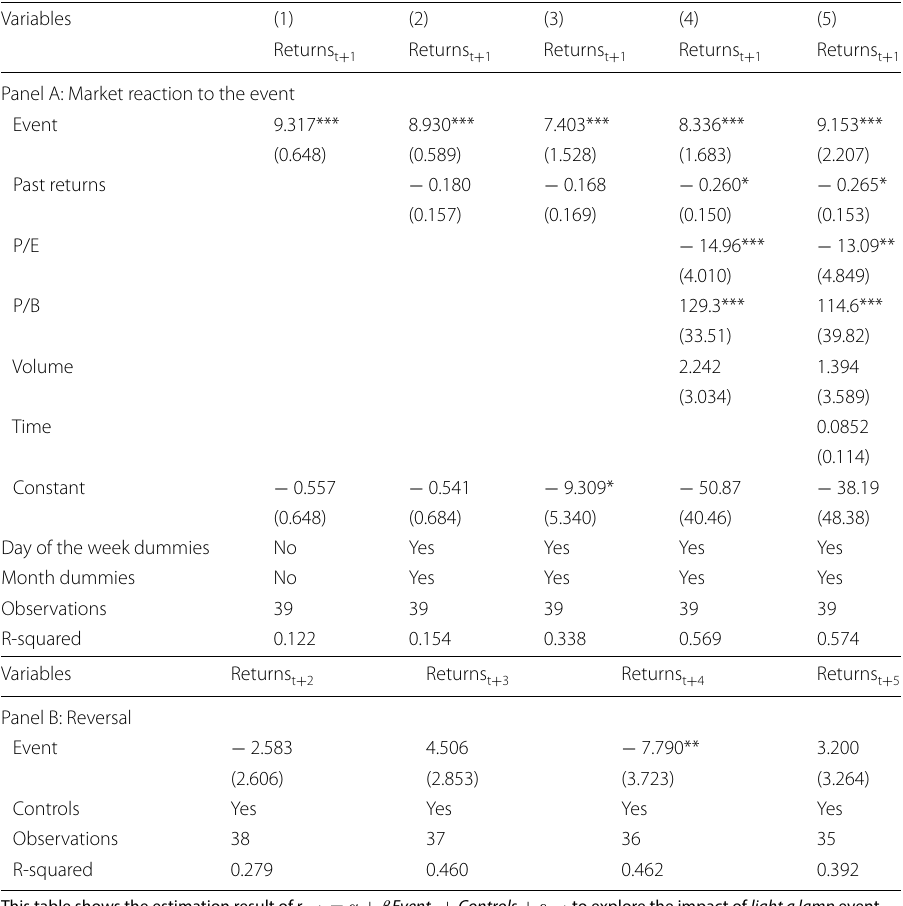
Table 1 Light a lamp and stock market